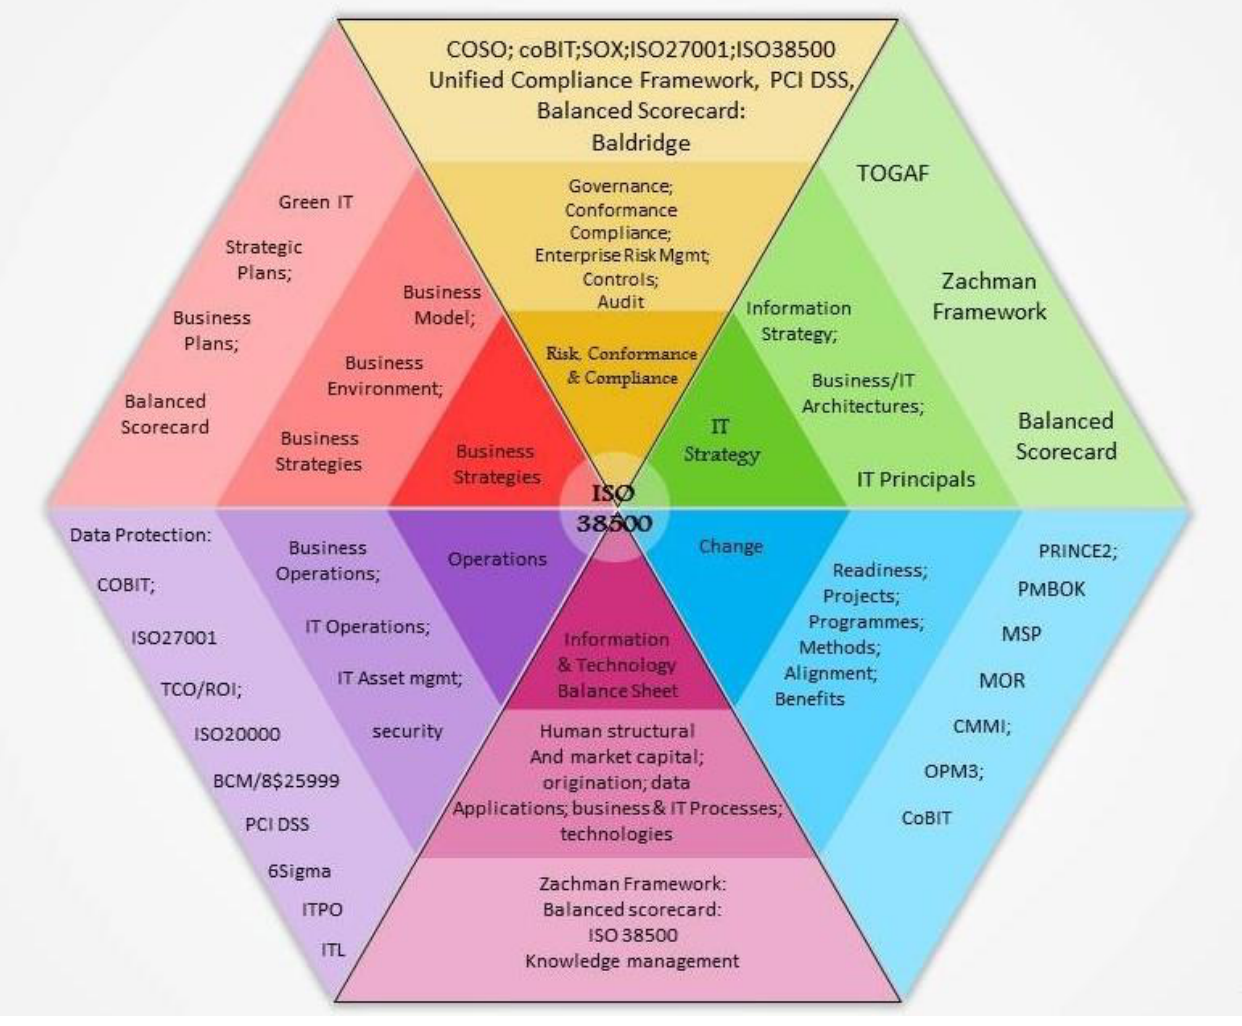
Figure 1. IT governance framework. The upper half covers the processes that determine directions, make plans and decisions, and establish constraints. The lower half covers processes that manage capabilities or develop new ones and use them to deliver products/services. Once the business strategies (red in figure), governance regimes, risk assessment, and controls have been developed (yellow in figure), IT works with the business to develop architectures and deliver plans based on those requirements (green in figure). The three layers into which the framework is divided, respectively, indicate the key issue for the board to consider (internal level), the executive management responsibilities (middle layer) and the issue related to IT practitioners (external layer) [7].